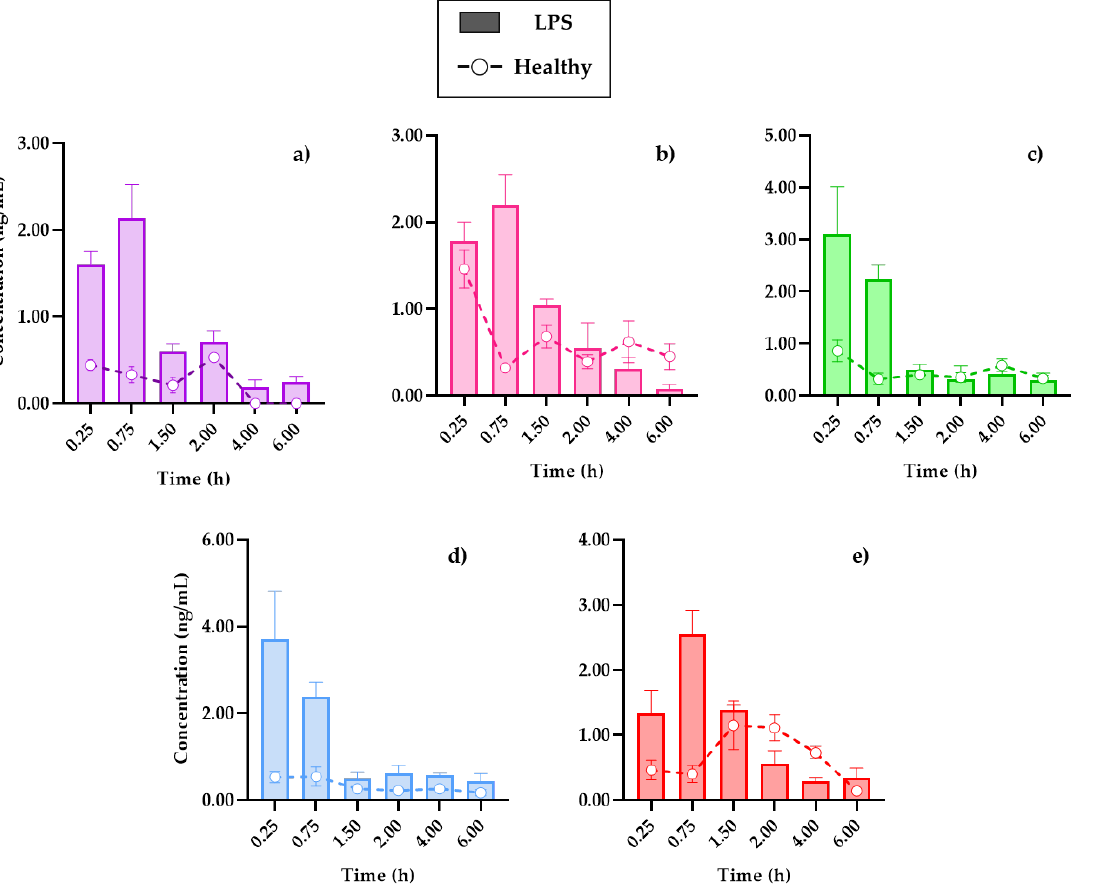
Figure 4. Distribution in the brain of ( a ) 7- O -prenylscopoletin (PE), ( b )scoparone (SC), ( c ) dimethylfraxetin (DF), ( d ) herniarin (HR), ( e ) 7- O -prenylumbelliferone (PU) after an oral dose administration of hexanic extract of Tagetes lucida in healthy and LPS-administrated mice. Values are presented as mean ± SEM ( n = 5).